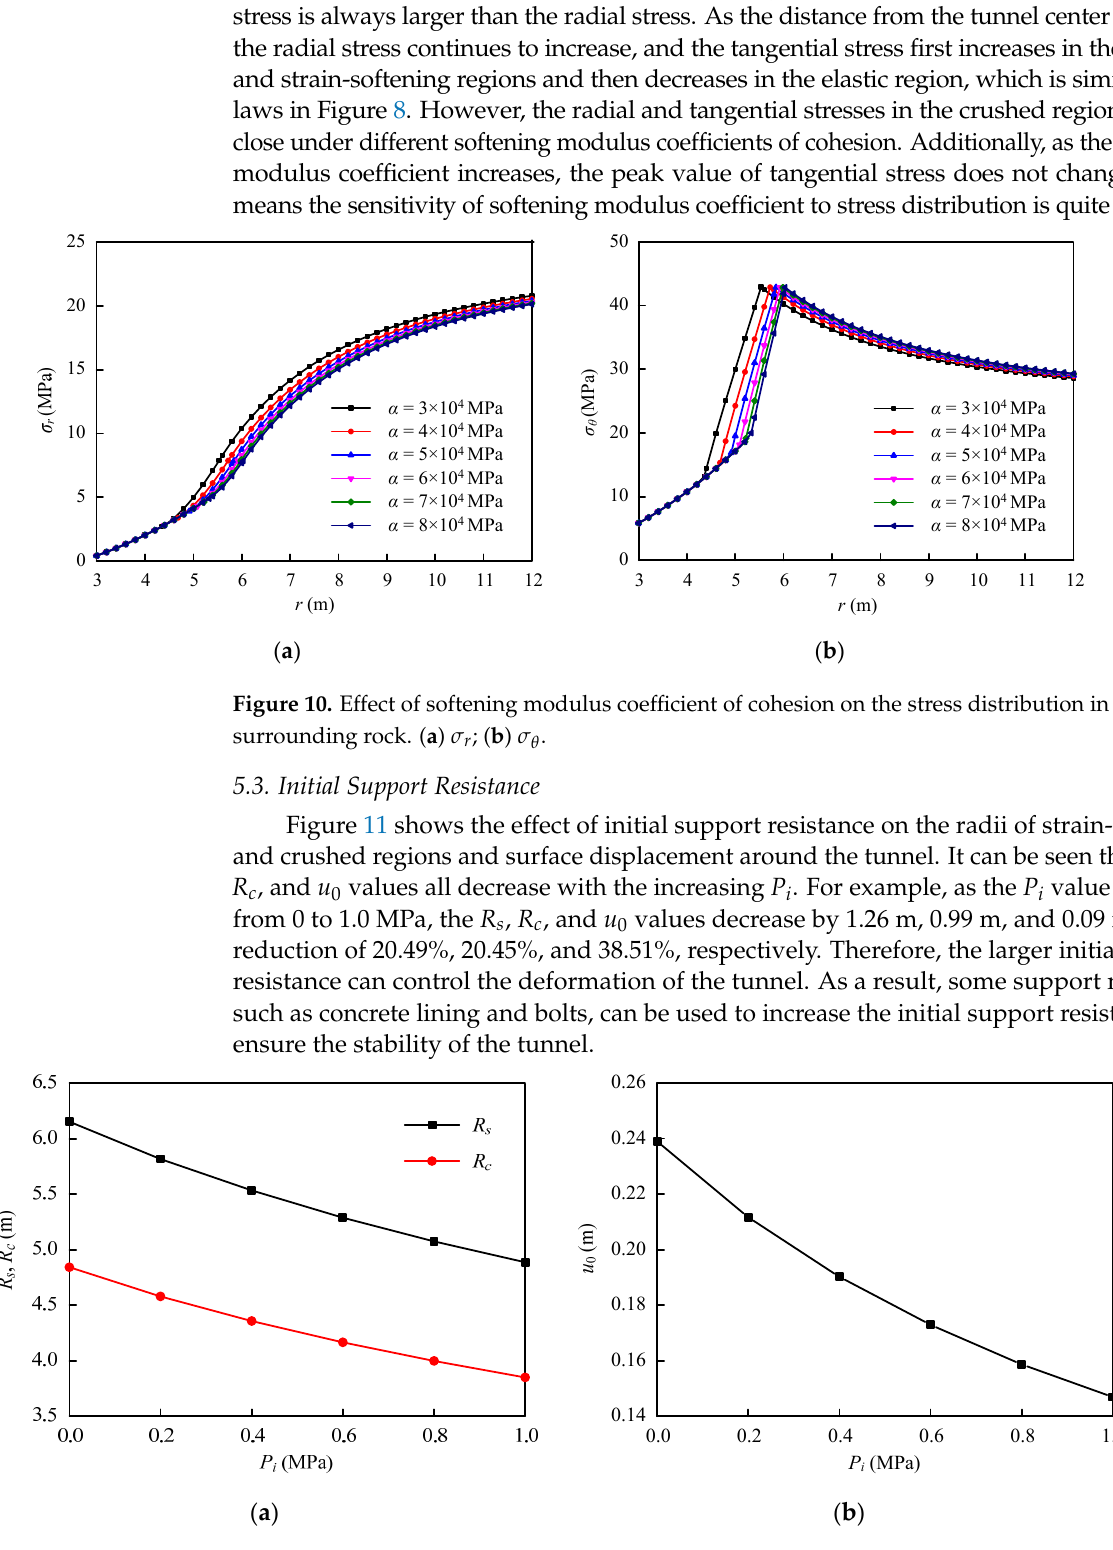
Figure 11. Effect of initial support resistance on the radii of strain-softening and crushed regions and surface displacement. ( a ) R s and R c ; ( b ) u 0 .